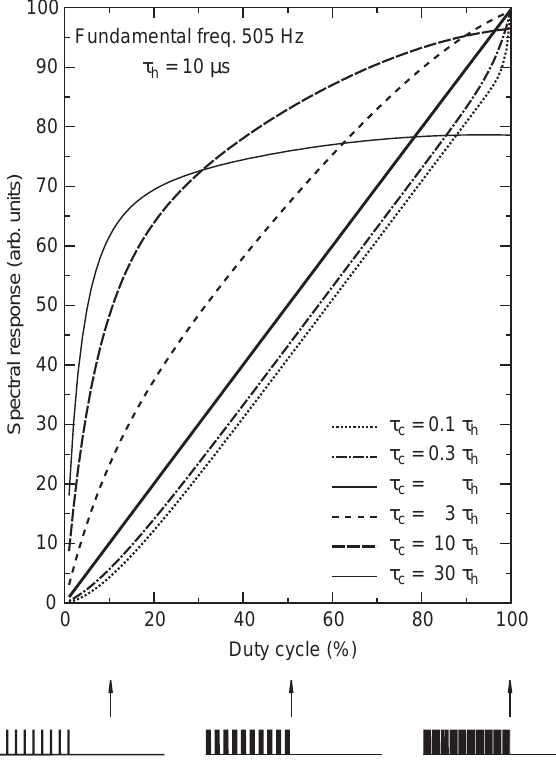
Fig. 5. Spectral response of ionospheric currents to a heating waveform of 505 Hz, pulse modulated with varying duty cycle (0– 100%) Fig. 4. ELF pulse response of ionosphere to heating with waveforms